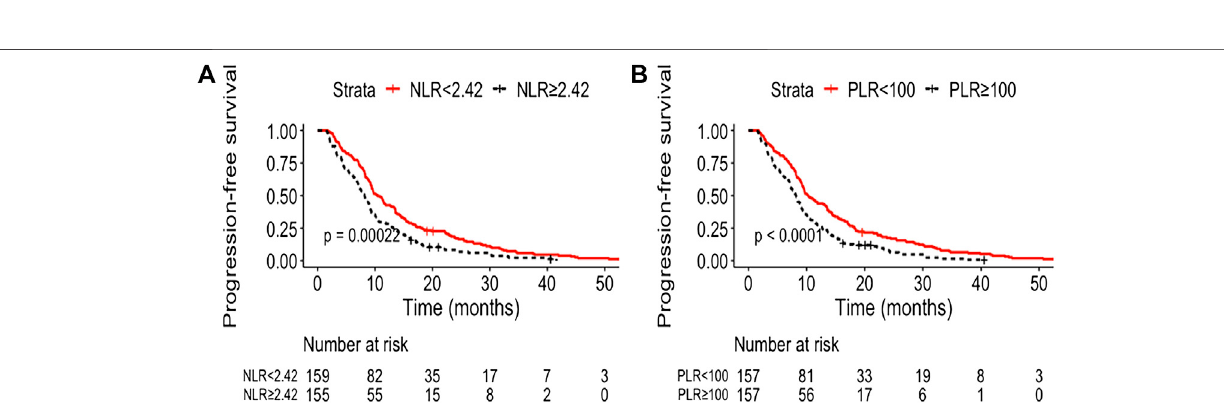
( Figure 2 ). The 1-year PFS rate of the low and high NLR/PLR group was 42.8% vs. 28.4% and 43.9% vs. 27.4%, respectively. The 1-year AUC of NLR and PLR was 0.684 and 0.681, respectively. The cut-off values of NLR and PLR correspond to sensitivity values of 54.8% and 53.9%, and speci fi city values of 45.2% and 42.8%, respectively ( Figure 3A ). The 3-year AUC of NLR and PLR was 0.621 and 0.581, respectively. The NLR and PLR